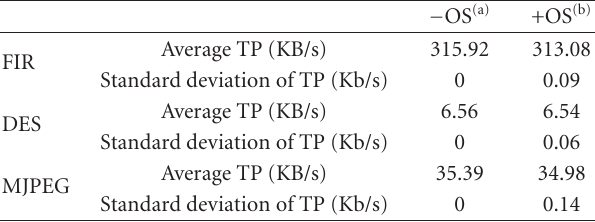
Table 5: FIR, DES, and MJPEG monolithic implementations and OS cost.